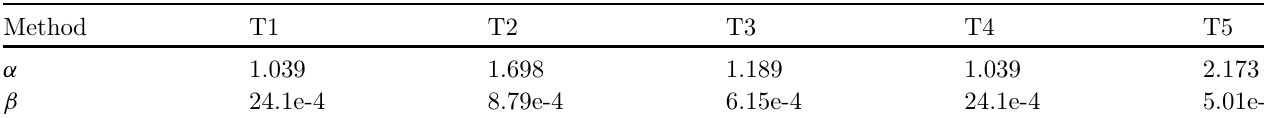
Table 3. Damping coef fi cient of the model.